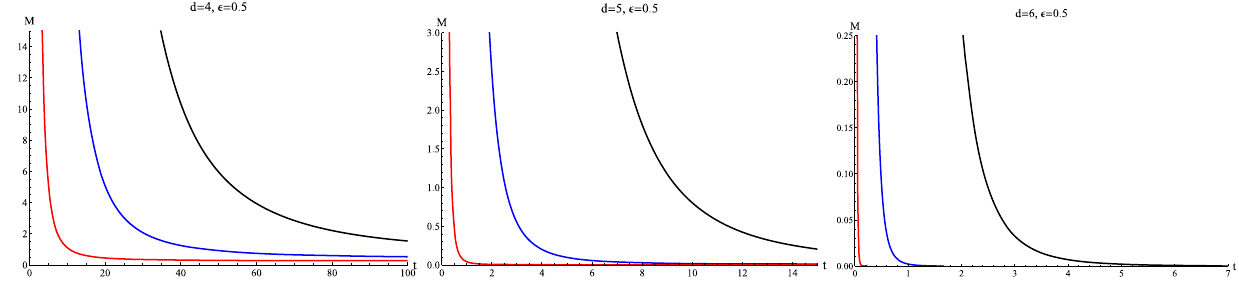
Fig. 4 The evolution of the black hole in d = 4 , 5 , 6 and (cid:2) = 0 . 5. The initial mass M 0 is taken to infinity. In each figure from left to right the curves correspond to (cid:3) = 0 . 1, (cid:3) = 0 . 15 and (cid:3) = 0 . 2,